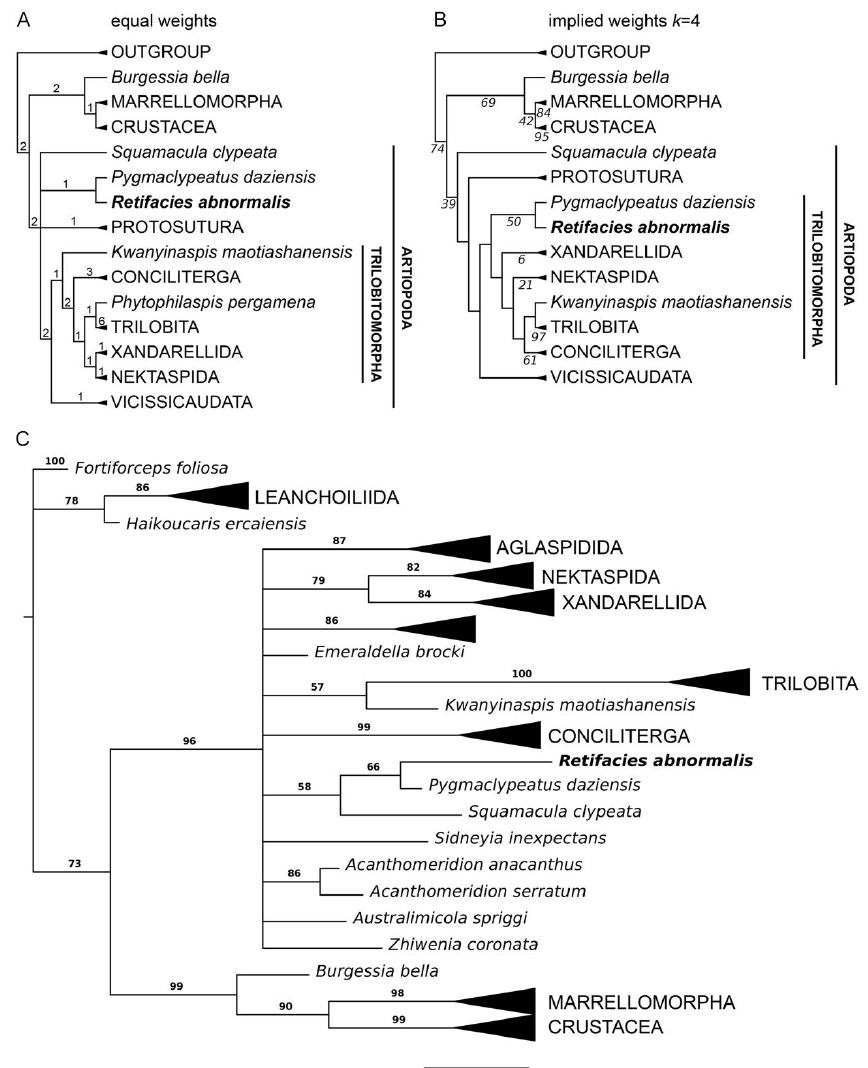
Figure 7. Phylogenetic position of Retifacies abnormalis within Artiopoda (Character matrix see the zip file character matrix S1). ( A ) Strict consensus of the four most parsimonious trees under equal weights (271 steps; CI: 0.413; RI: 0.734); numerals indicate Bremer support values. ( B ) Single most parsimonious tree under implied weights (k = 4; CI: 0.404; RI: 0.724); italicized numerals indicate nodal support by frequency differences (GC) with symmetric resampling performed with 100 replicates. ( C ) Consensus tree resulting from Bayesian analysis in MrBayes. Mk model, four chains, 1,000,000 generations, 1/1000 sampling with 25% burn-in; bold numerals denote posterior probability